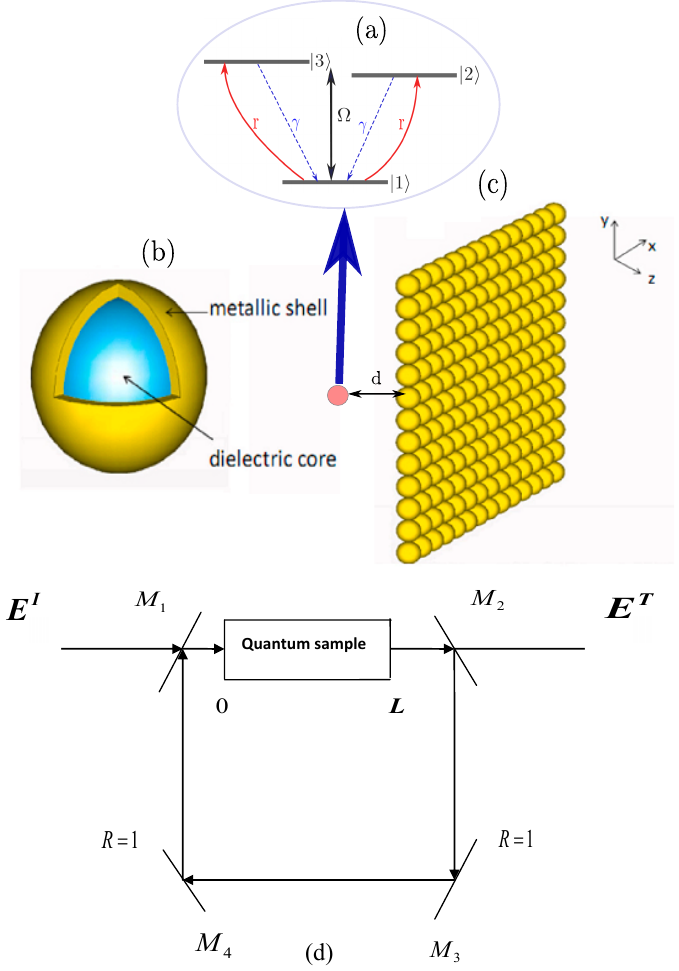
Figure 1. The three-level quantum V -system under study ( a ). A silica sphere coated with a gold nanoshell ( b ) and a two-dimensional square lattice of such spheres ( c ). The quantum sample (quantum emitter + array of spheres) is placed inside a unidirectional ring cavity ( d